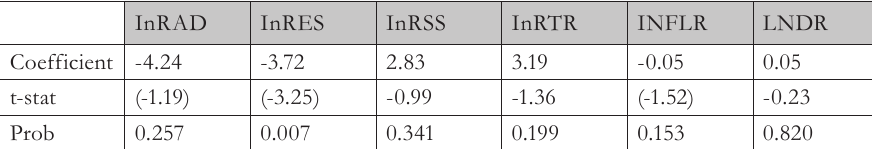
Tab. 12 – Long run Coefficient Result for Recurrent Expenditure Model. Source: